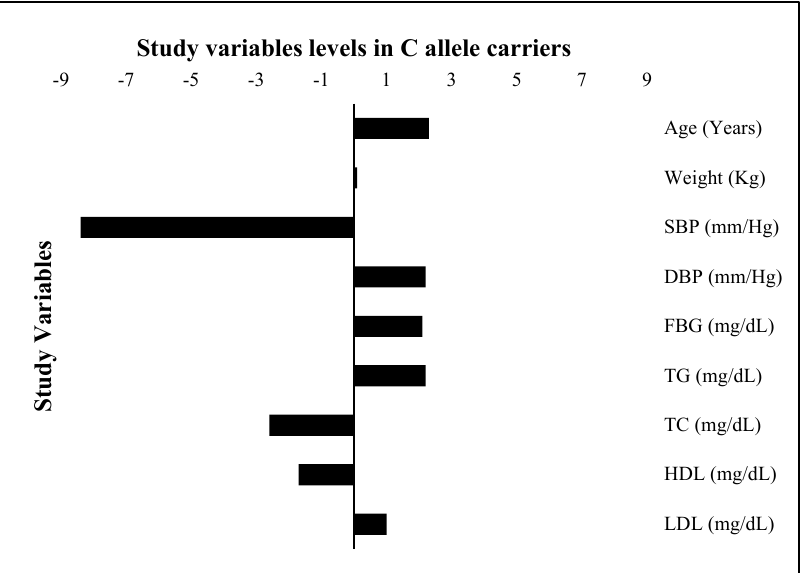
Figure 4. Study variable levels (SD change from population means) in C allele carriers. The levels of all study variables are presented as a standard deviation (SD) change from the population means in C allele carrier (GC heterozygotes and CC homozygotes combined) study subjects. The bars with +ive (>0) values represent higher/raised levels while those with − ive (<0) values show lower levels of individual variables in C allele carriers as compared with the G allele carriers.